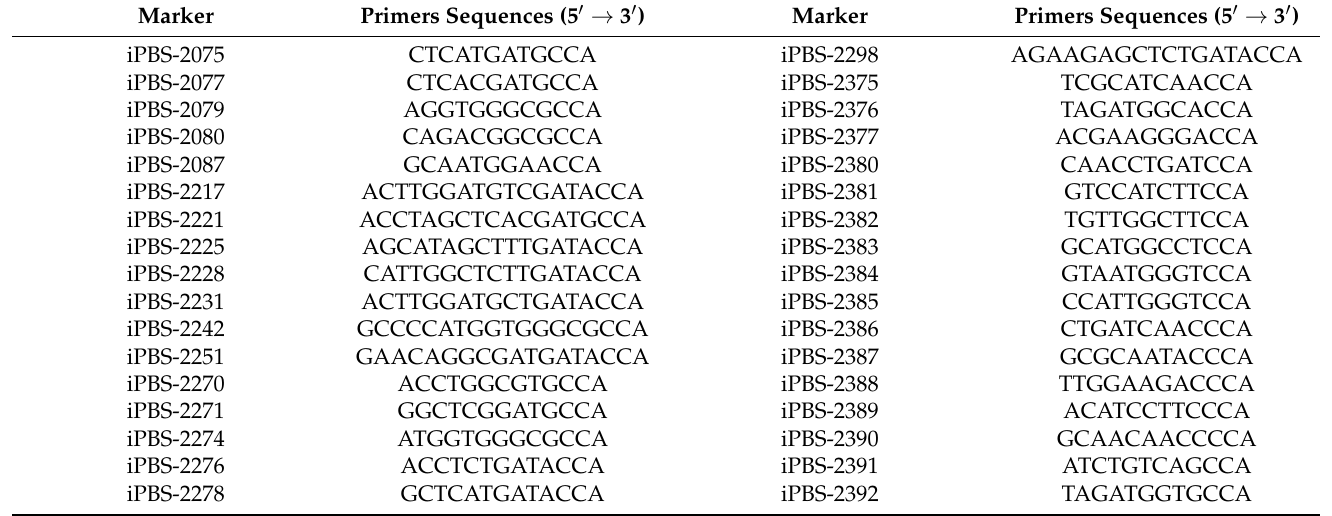
Table 2. List of 34 iPBS-retrotransposon primers with their sequences used to elucidate genetic diversity among 63 bread wheat